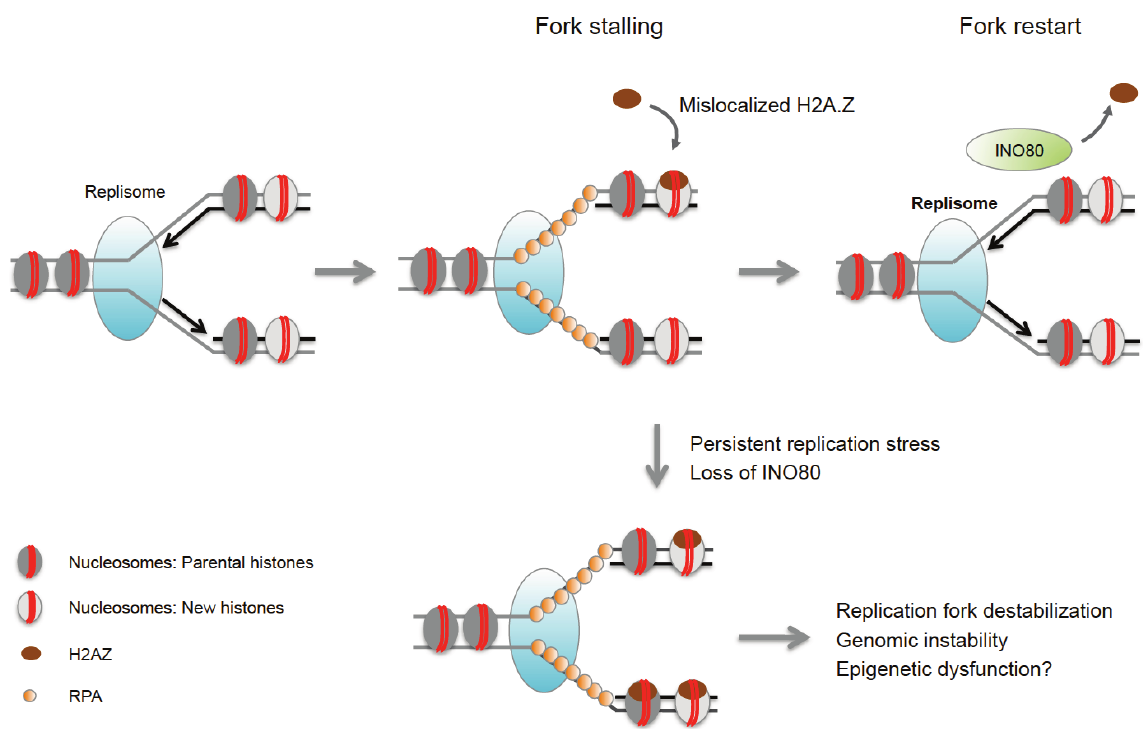
Figure 1. INO80 stabilizes replication forks and counteracts mislocalization of